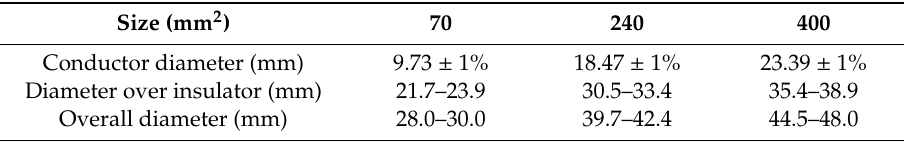
Figure 26. The 24 kV cross-linked polyethylene (XLPE) underground cable structure. Table 5. Conductor size of the 24 kV XLPE underground cable.